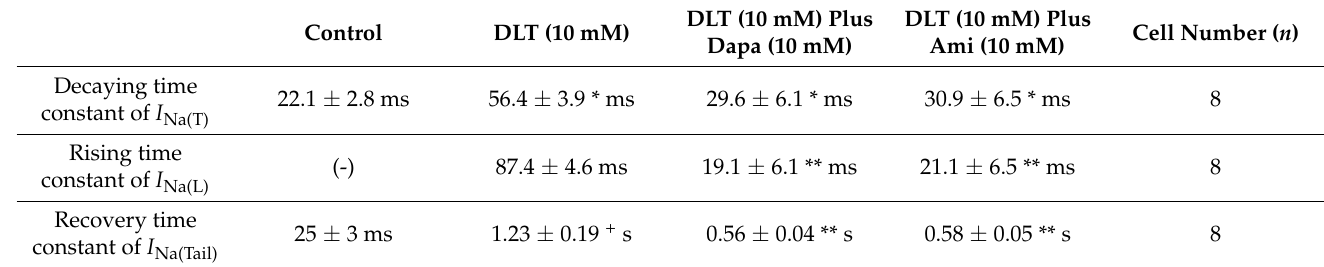
Table 1. Effects of DLT, DLT plus dapagliflozin (Dapa, 10 mM), and DLT plus amiloride (Ami, 10 mM) on either the decaying time constant of I Na(T) during pulse train (PT) stimulation (i.e., cumulative inhibition of I Na(T) during rapid depolarizing stimuli) or the rising time constant of I Na(L) during